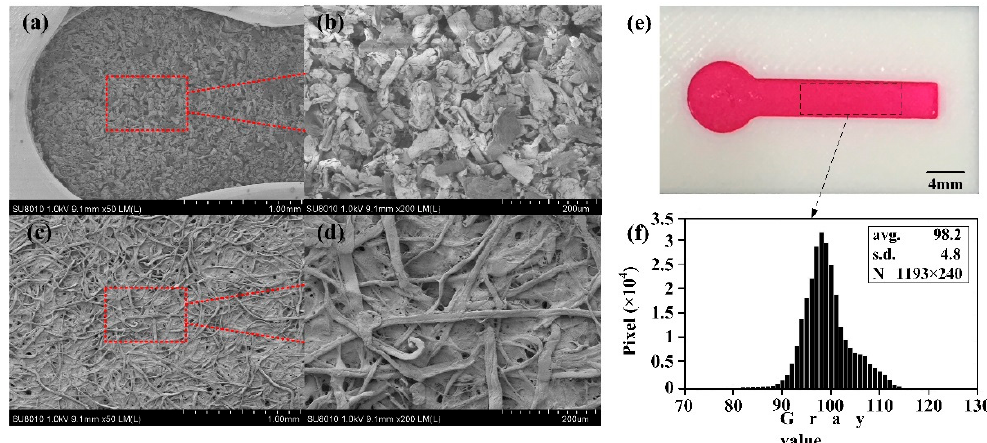
Figure 4. Scanning electron microscopy of cellulose powder in fabricated device and Whatman No. 1: ( a ) Microstructure of cellulose powder under microscope (50×); ( b ) Microstructure of cellulose powder under microscope (200×); ( c ) Microstructure of chromatography paper Whatman No. 1 under microscope (50×); ( d ) Microstructure of chromatography paper Whatman No. 1 under microscope (200×); ( e ) A dying test on a μ 3DPAD with a channel of 4 mm width; ( f ) Gray value distribution of the dye in the channel .